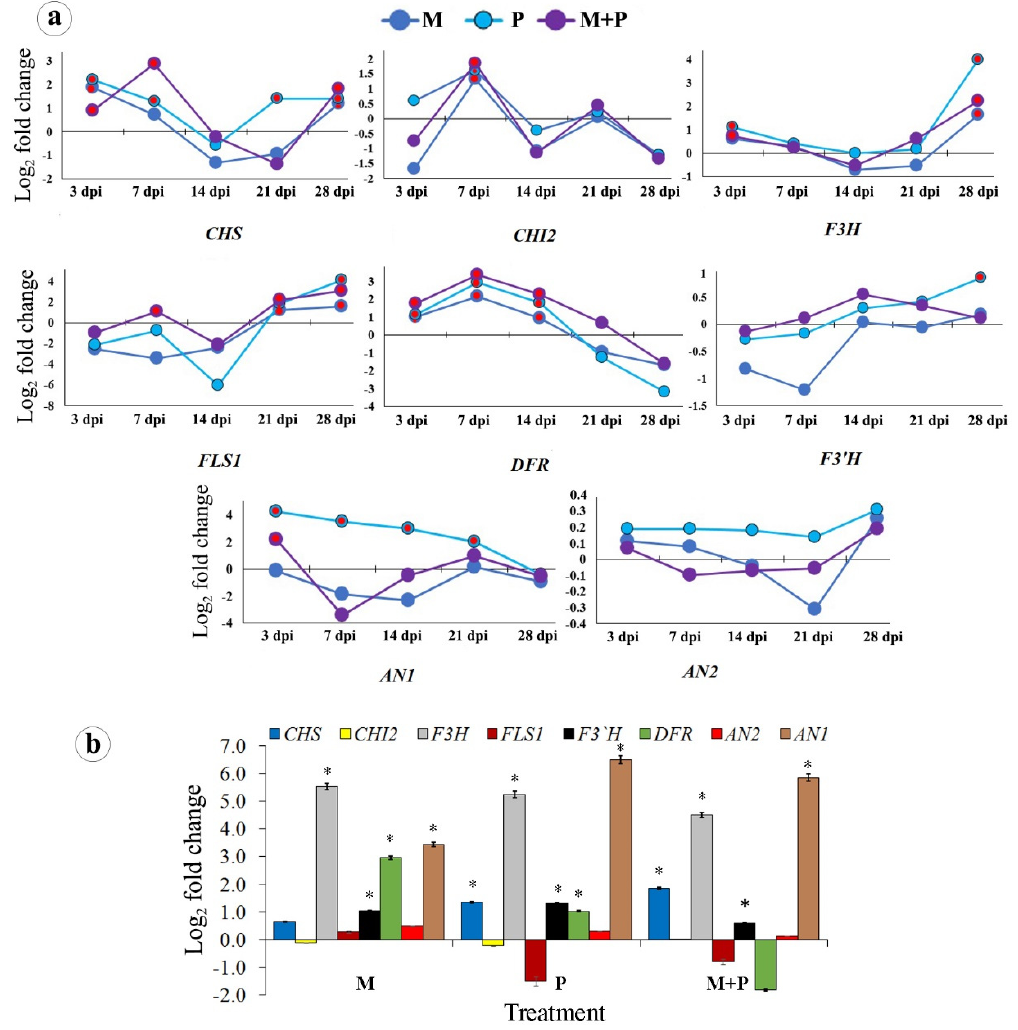
Figure 3. Change in the transcriptional expression levels of the flavonoid biosynthetic pathway genes in sunflower leaves at 3, 7, 14, 21, and 28 dpi ( a ), and roots at 28 dpi ( b ) in response to colonization with R. irregularis and/or infection with R. solani . Where, M = colonized with R. irregularis , P = infected with R. solani , and M+P = colonized with R. irregularis and infected with R. solani . For each gene in the subfigure ( a ), treatments marked with red are significantly different at p ≤ 0.05. In the subfigure ( b ), bars indicate the standard error, and for each gene, columns superscripted with asterisks are significantly different at p ≤ 0.05.